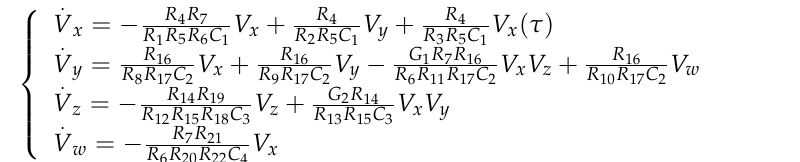
Figure 10. Time-delay Lorenz chaotic circuit.